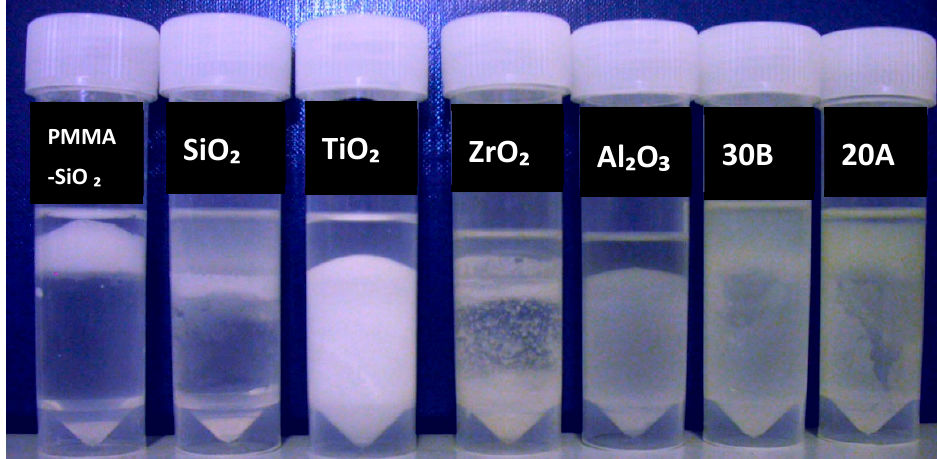
Figure 6. Particles stored for one hour after mixing with monomer, prior to silane treatment, from left to right; impregnated PMMA by silica, silane treated silica (control), untreated TiO 2 , ZrO 2 , Al 2 O 3 and nanoclays 30B and 20A.